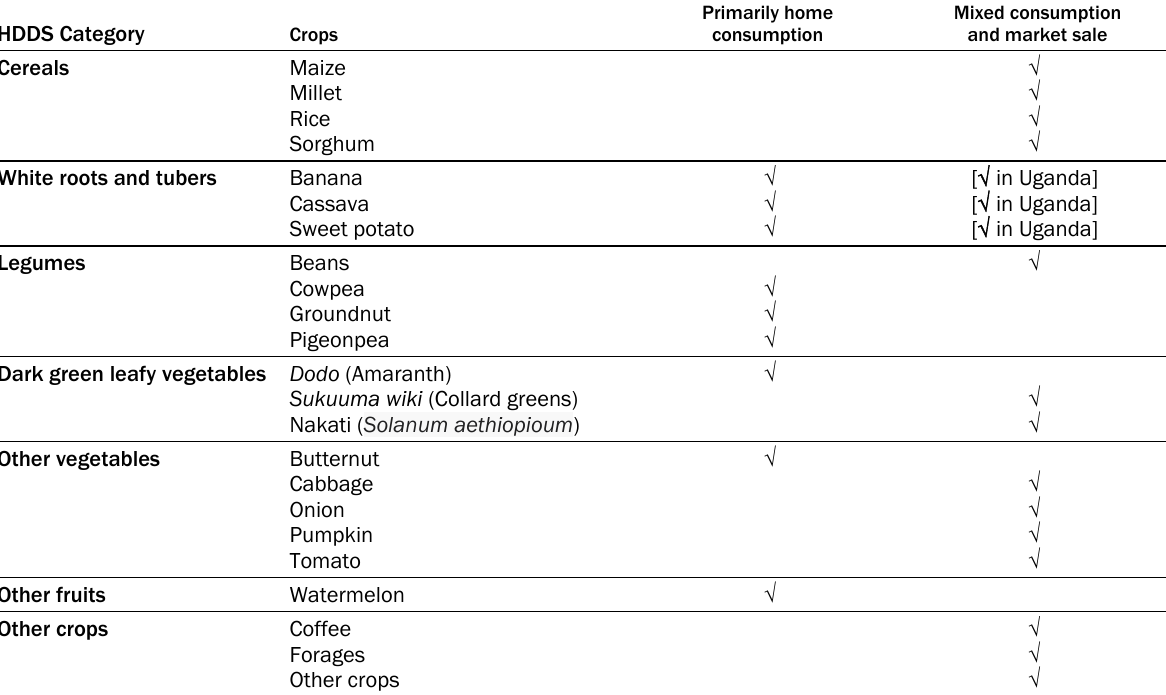
Table 2. Crop Classification by Household Dietary Diversity Score (HDDS) Categories and Common Local